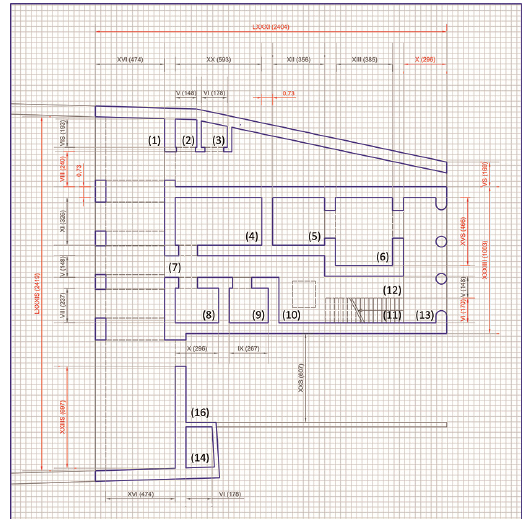
Figure 3. Edificium custodiae. Use of a grid derived from the thickness of the walls. The measure-module measures the parts. The numbers of the rooms refer to the functional distribution referred to in